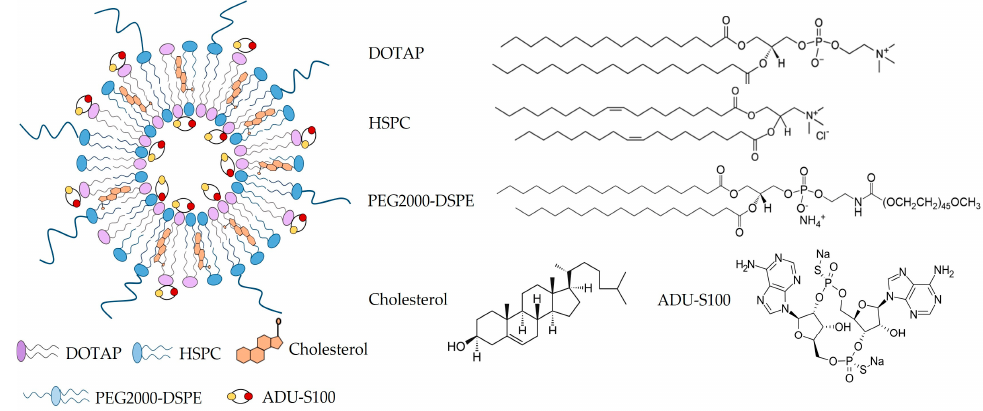
Figure 1. Schematic representation of ADU-S100-loaded liposome and the chemical structures of the individual components. DOTAP, HSPC, and PEG 2000 -DSPE are assembled into the lipid bilayer, and cholesterol is inserted within the lipid bilayer. ADU-S100 can be associated with both the interior and exterior of the liposome bilayer by complexing with the cationic amino headgroup in DOTAP.